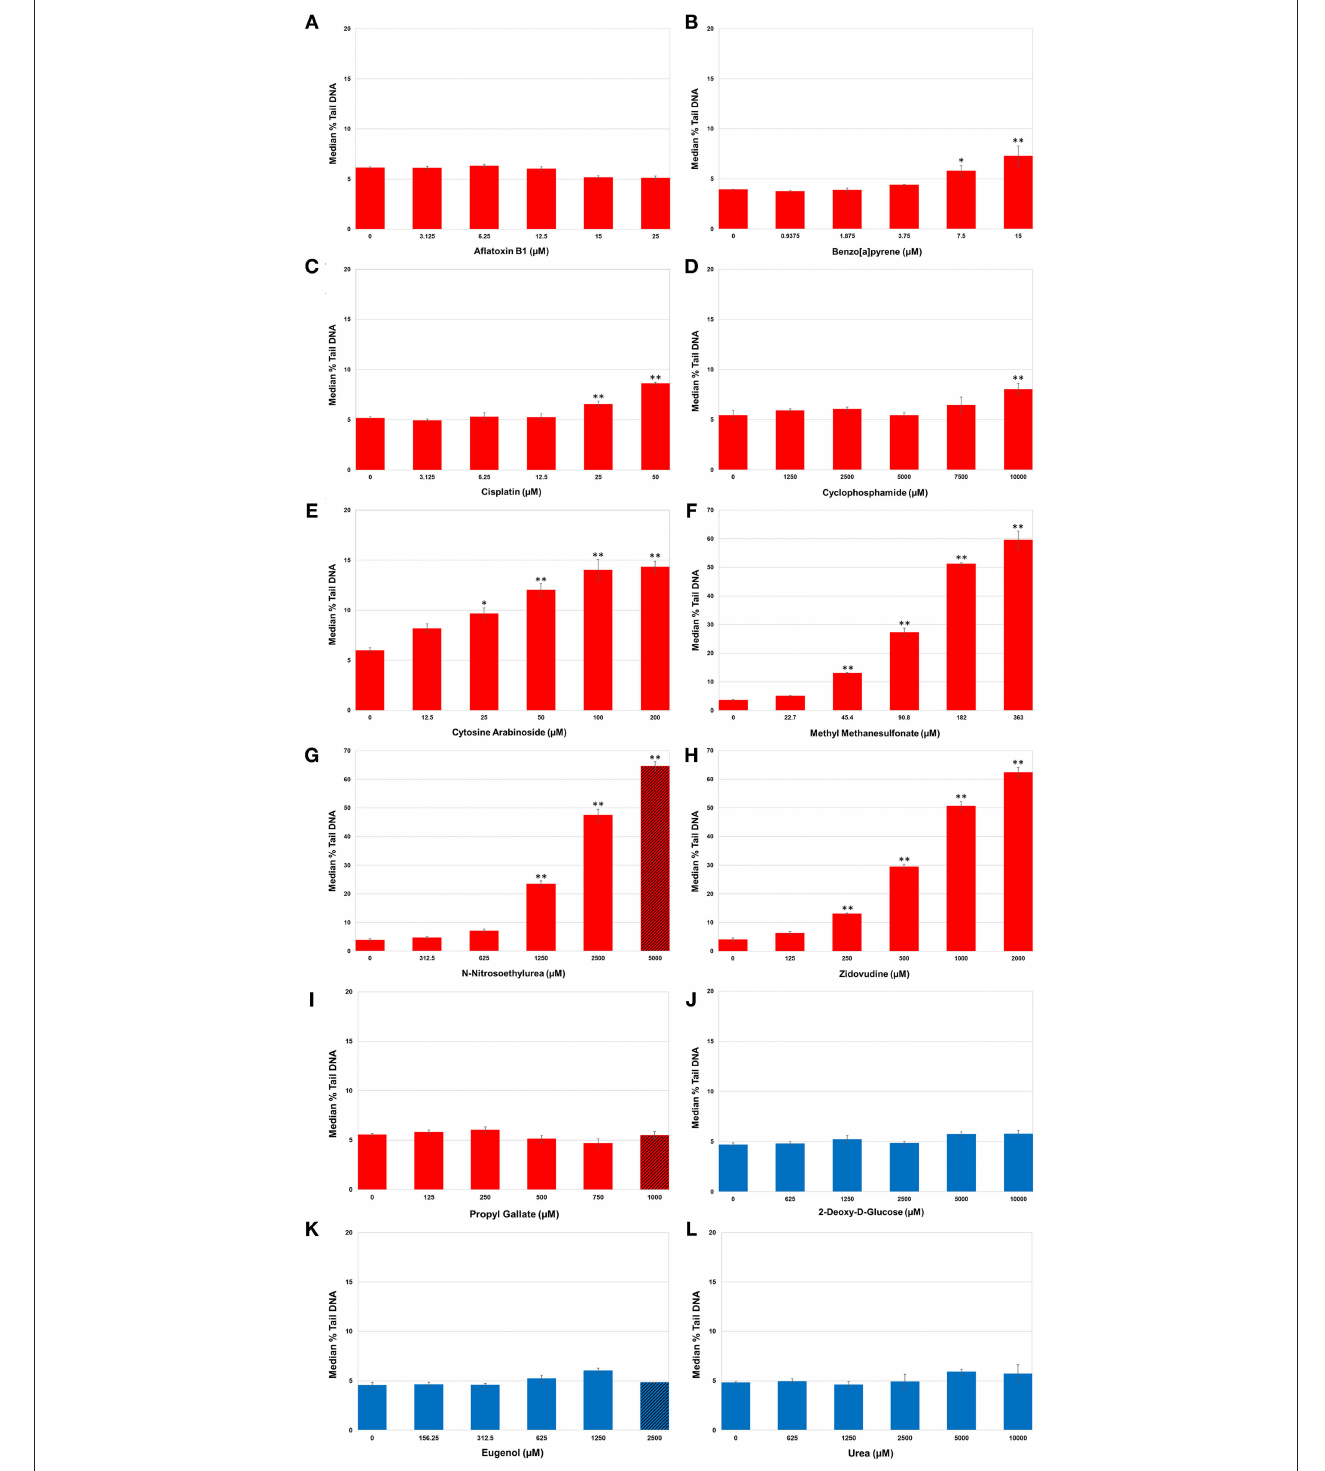
FIGURE 2 | DNA damage in human HepaRG TM cells measured using the alkaline CometChip ® assay. Cells were exposed to increasing concentrations of DNA damage-inducing (DDI; A–I) and non-DDI test chemicals (J–L) . Median % tail DNA is shown 4h following the last exposure. The data are expressed as the median % tail DNA ± SE ( n = 4). Red bars represent Group 1 DDI chemicals, blue bars denote the Group 2 non-DDI chemical and the Group 3 potentially misleading positive chemicals. Diagonal lines indicate overtly cytotoxic concentrations. Note the difference in the scale of the y-axis for MMS, ENU, and ZDV due to the large magnitude of the response for these three DDI (Group 1) chemicals. * P < 0.05, ** P < 0.001 compared to matched vehicle control.